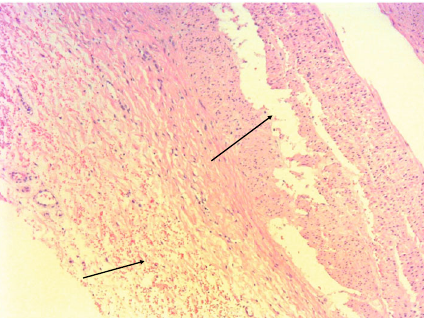
Figure 4: Pig #4. The arrows indicate renal artery wall dissection and hemorrhagic impregnation after RF ablation. Hematoxylin- eosin,